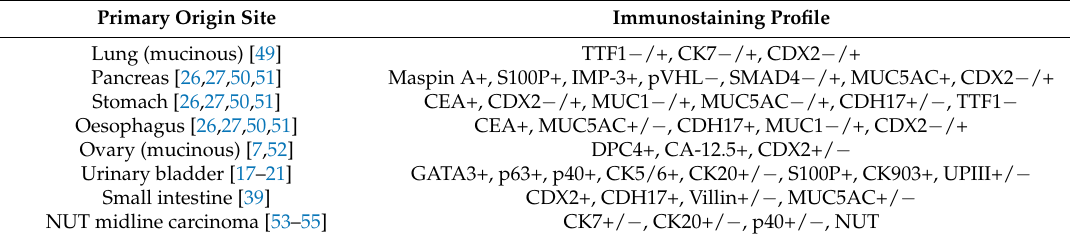
Table 4. IHC tumour staining patterns in the differential diagnosis of CUPs expressing CK7+/CK20+